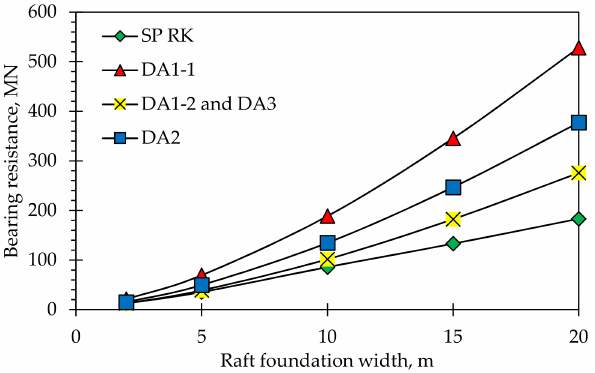
Figure 7. Bearing resistance of raft foundations of varying widths.